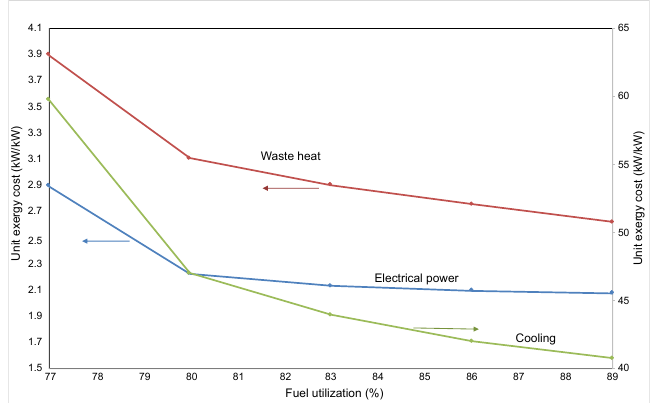
Figure 8. Variation of the unit exergy cost of electricity and exhaust gases as a function of the fuel use (FU).